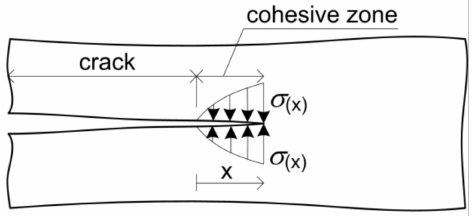
Figure 2. Barenblatt model